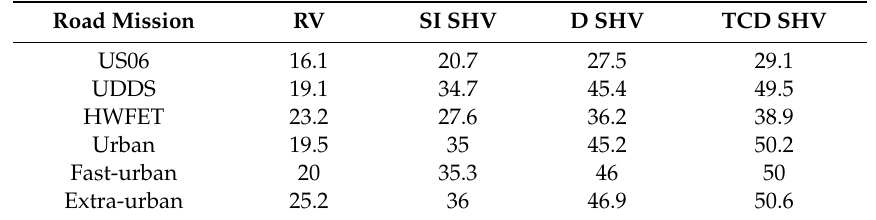
Table 7. Fuel economy of di ff erent hybrid electric vehicle (HEVs) over di ff erent road missions (km / L).